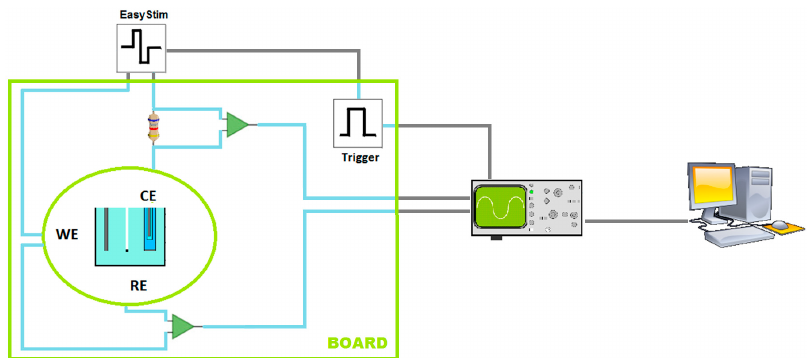
Figure 2. VT measurements—Simplified diagram of measurement setup: WE is the working electrode, RE is the reference electrode, CE is the counter electrode. Custom circuit board and oscilloscope to capture signals. Stimulator (EasyStim) and computer for signal processing.